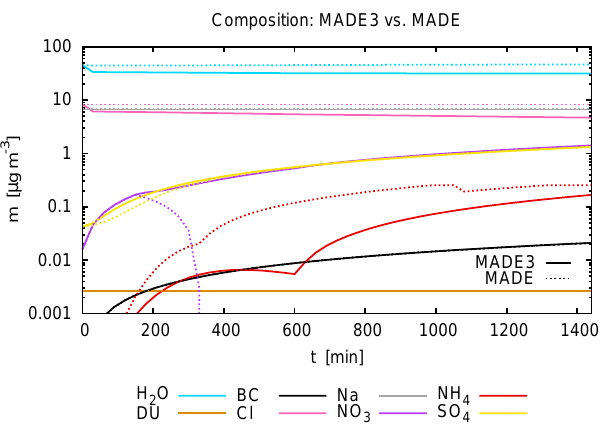
Figure 5. Initial (grey, black) and final (light red, red) size distri- butions in MADE3 and PartMC-MOSAIC vs. dry diameter (i.e. ne- glecting aerosol water). Light colours (grey, light red) are used for number distributions (left vertical axis), full colours (black, red) for dry mass distributions (right vertical axis). MADE3 output is shown as solid lines, PartMC-MOSAIC output as crosses. The inset mag- nifies the coarse mode dry mass size